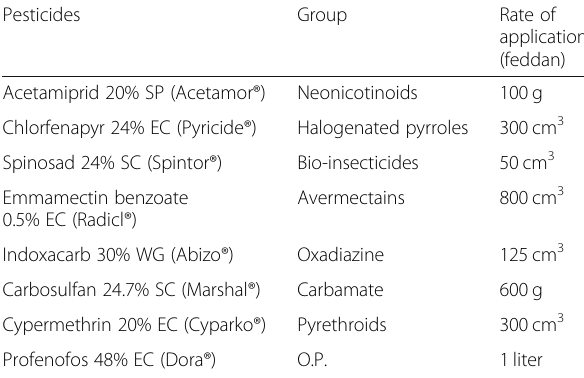
Table 1 Recommended and used doses of the tested